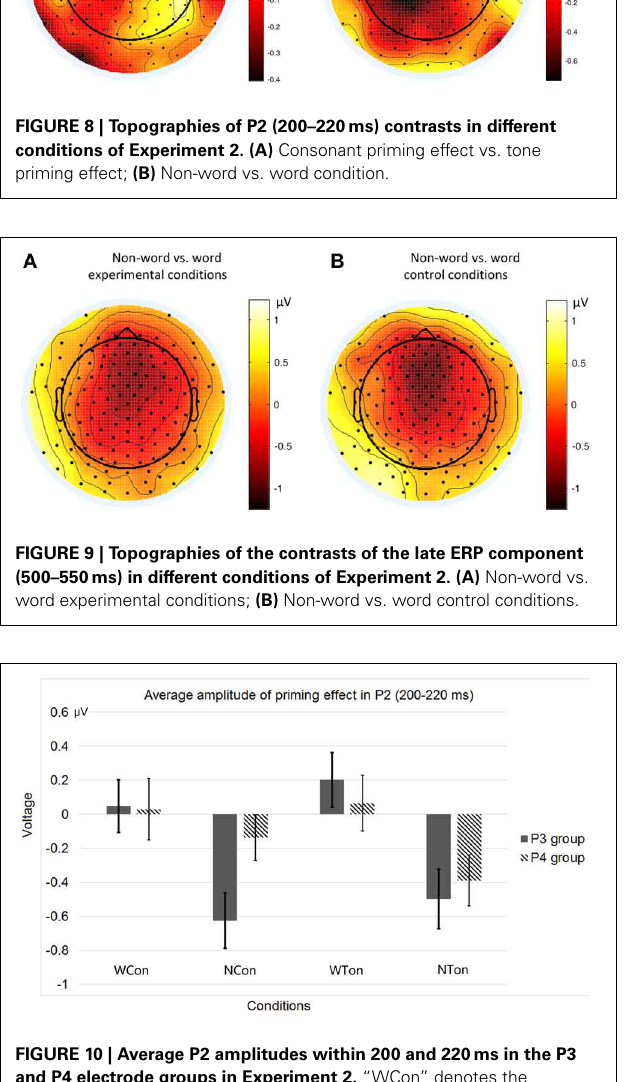
FIGURE 10 | Average P2 amplitudes within 200 and 220ms in the P3 and P4 electrode groups in Experiment 2. “WCon” denotes the comparison between the word, consonant priming condition and the word, control condition, and “NCon” between the non-word, consonant priming condition and the non-word, control condition, “WTon” between the word, tone priming condition and the word, control condition, “NTon” between the non-word, tone priming condition and the non-word, control condition.